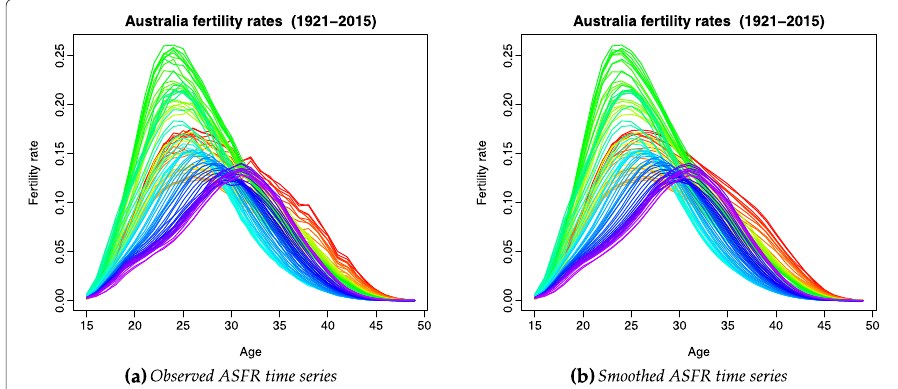
Fig. 5 Observed and smoothed ASFRs for Australia, 1921 to 2015. The data are represented chronologically by the colours of the rainbow from red to violet (most